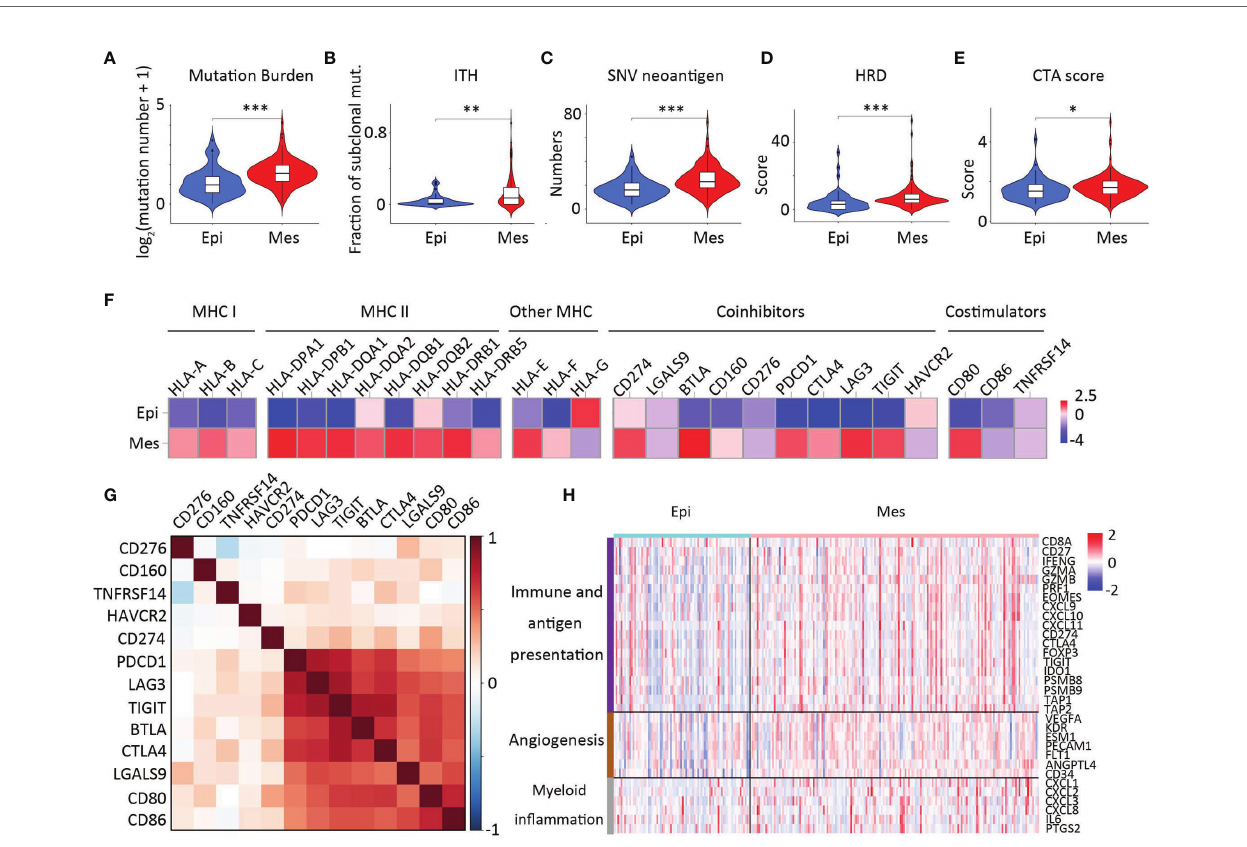
FIGURE 7 | Intrinsic immune escape mechanisms of EMT subtypes. Comparison of mutation burden (A) , ITH (B) , SNV neoantigen (C) , HRD scores (D) , and CTA numbers (E) among the two clusters. In the violin plots, the mean values are plotted as red dots, and the boxplot was drawn inside the violin plot. (F) Comparison of the log2-fold changes in mRNA expression at the tumor sites of the MHC molecules, costimulators, and coinhibitors for each cluster. For costimulators, only molecules having signi fi cantly differential expression between two clusters (except CD274 and CD276, P < 0.01) were illustrated. (G) Correlations between expression of immune checkpoint molecules. (H) Heatmap showing expression of genes related to angiogenesis (brown), immune and antigen presentation (purple), and myeloid in fl ammation (gray) were z-score transformed before